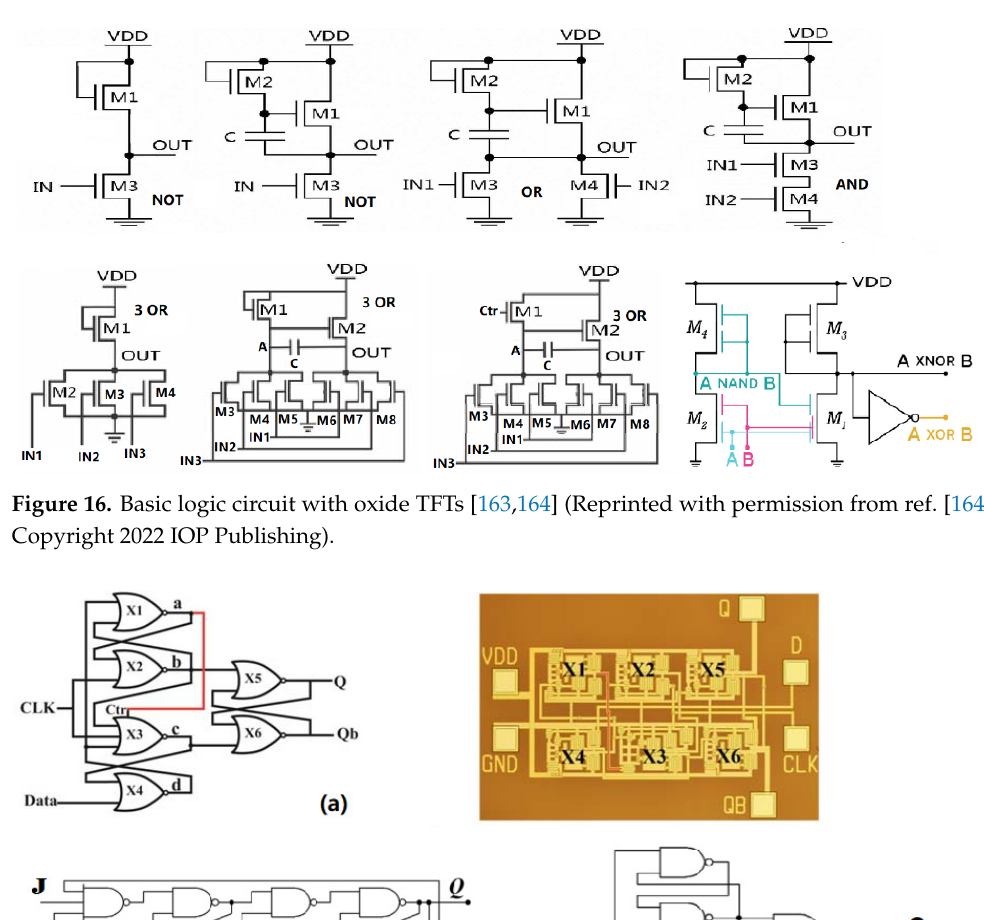
Figure 16. Basic logic circuit with oxide TFTs [163,164] (Reprinted with permission from Ref. [164]. Copyright 2022 IOP Publishing).